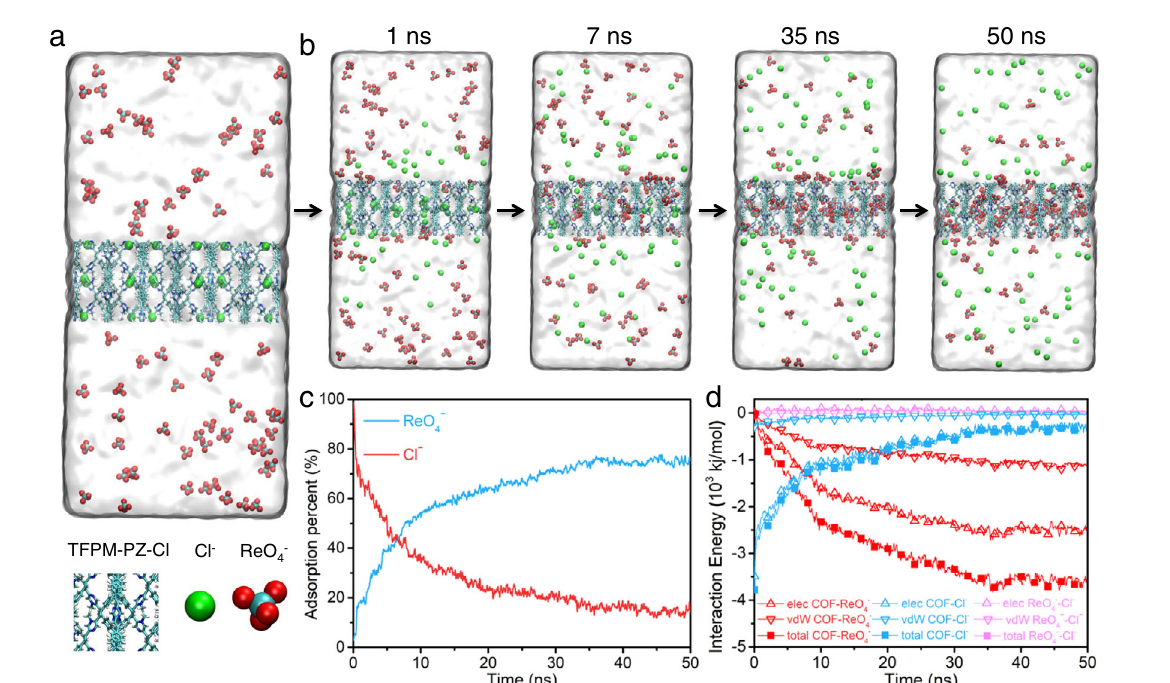
Fig.6|KineticsimulationontheadsorptionofReO 4 − .a Kineticsimulationinitial con fi guration (0ns), water with a transparent surface. b Time series snapshot showing the ion exchangeprocess. c Time evolution of the anion exchange rate of ReO 4 − (blue) and the residence rate of Cl − (red) in TFPM-PZ-Cl. d Variation of